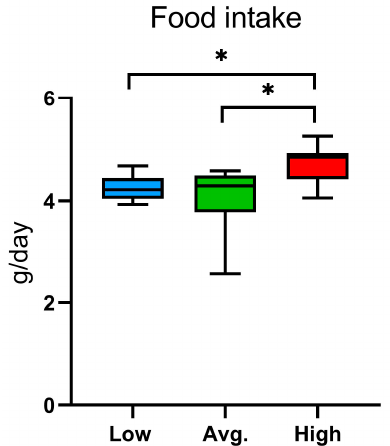
Figure 3. Food intake in the running wheel groups (Low; n = 7, Avg.; n = 8, High; n = 7) in the PhenoMaster. Statistically significant differences are indicated with an asterisk: * p < 0.1. Data are presented as mean and standard deviation.